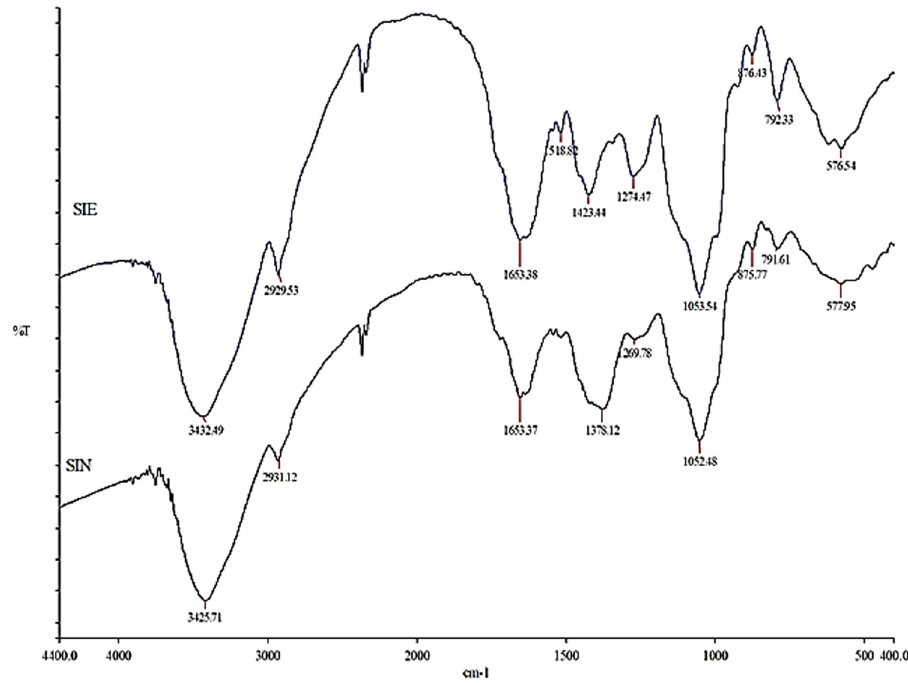
Figure 6: Fourier - transform infrared spectrum of the Sisymbrium irio seed extract and synthesized Si -